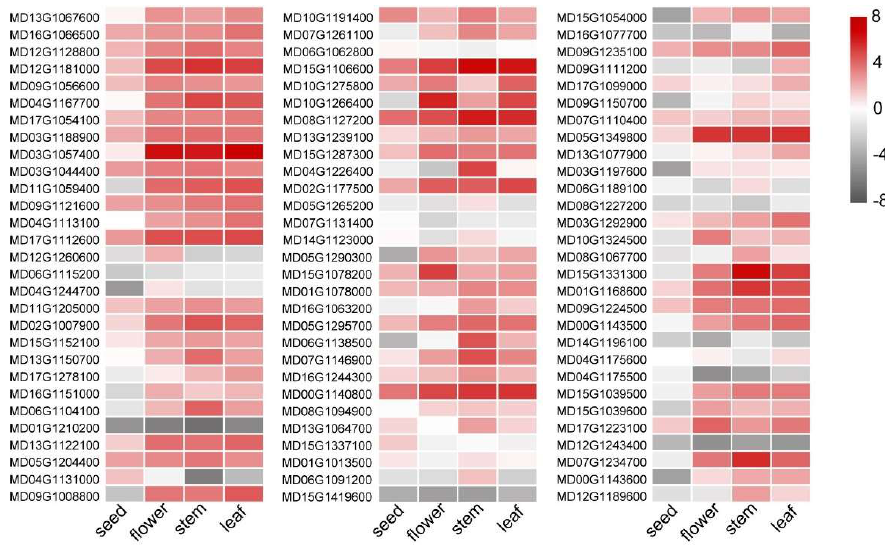
Figure 5. Expression analysis of MdWRKY genes in various tissues of apple. Expression profile data were obtained from Apple MDO database. The visualization of the result was achieved using TBtools.